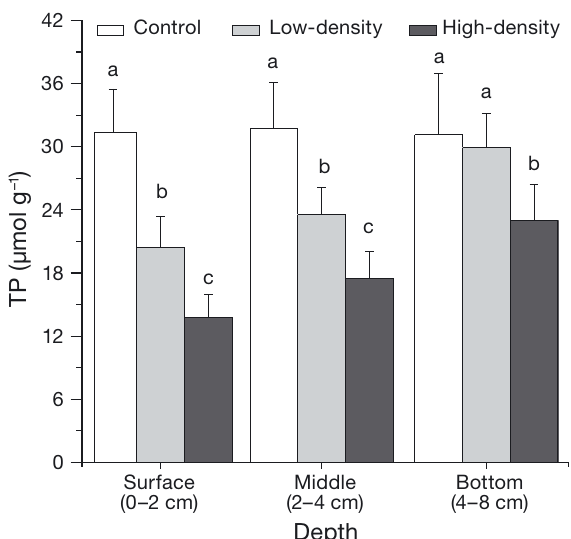
Fig. 3. Concentration (mean ± SD; n = 4) of vertical total phos- phorus (TP) in the 3 sediment layers for each Tegillarca gra- nosa treatment group. Letters denote significant differences (p < 0.05) within the same